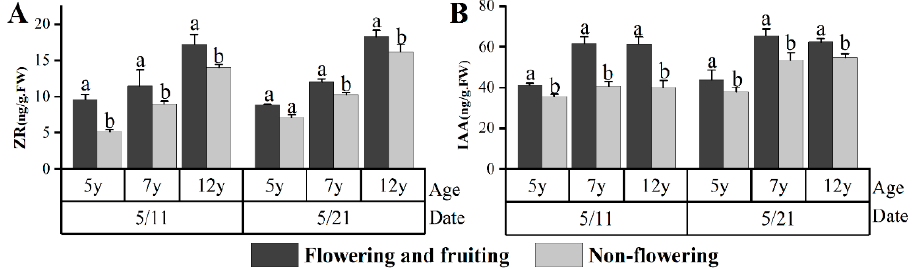
Figure 3. E ff ects of the endogenous hormone contents on G. uralensis Fisch. flower bud formation. Di ff erent letters reflect significant di ff erences among di ff erent indexes in the same stage: ( A ) ZR content, ( B ) IAA content.